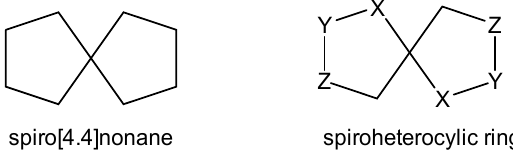
Chart 1. Spirocyclic compounds.